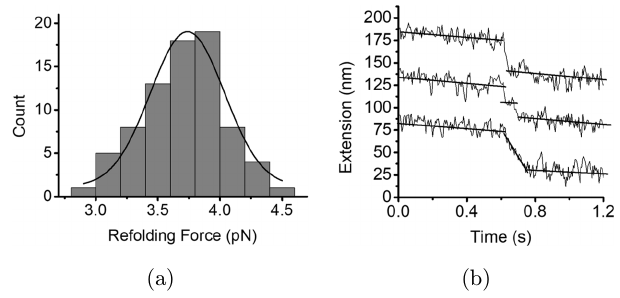
Fig. 4. The ¯rst folding step of (cid:1) -CM molecule during force- decreasing process at constant loading rate of (cid:2) 2 pN/s. (a) Histogram of refolding force of this ¯rst folding step. The red line represents Gaussian ¯tting curve. The data are from 77 independent unfolding events. (b) Three typical folding steps at (cid:3) 3 : 6 pN. Curves are shifted vertically for clarity. Top one shows a single step of (cid:3) 34 nm. Middle one shows two conse- cutive steps of (cid:3) 17 nm. Bottom one shows a continuous linear folding process with